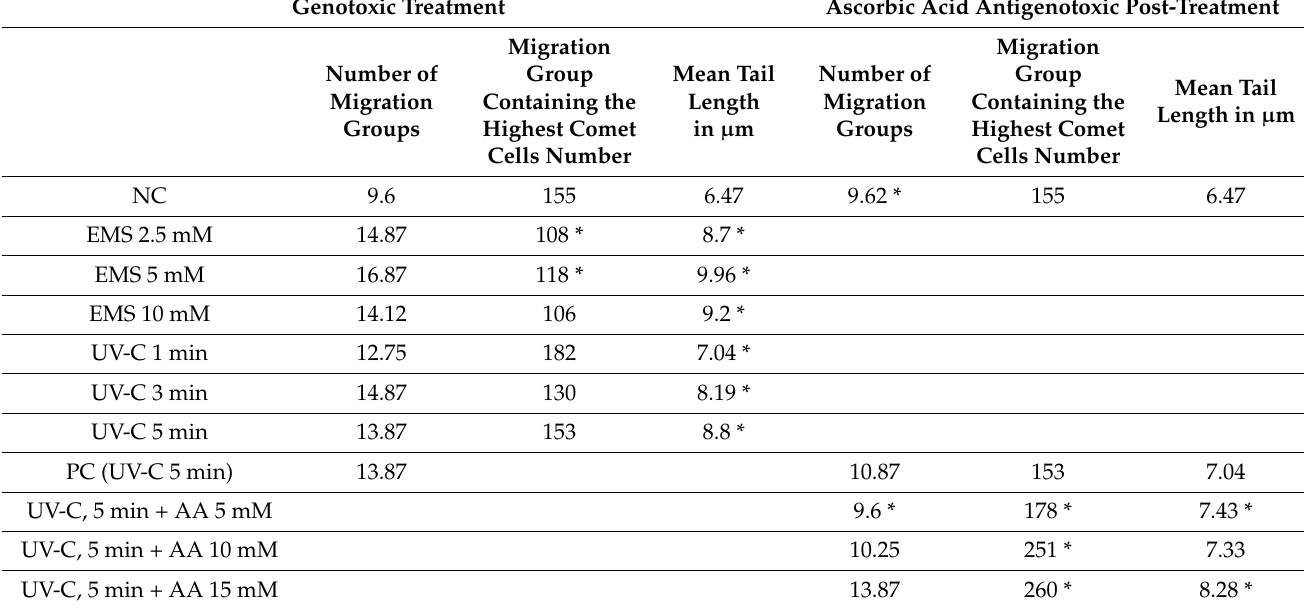
Table 1. Genotoxic and antigenotoxic treatments in Oreochromis niloticus erythrocytes. The genetic damage was observed using the number of MGs, migration groups with the highest comet cell number, and the mean tail length observed in each